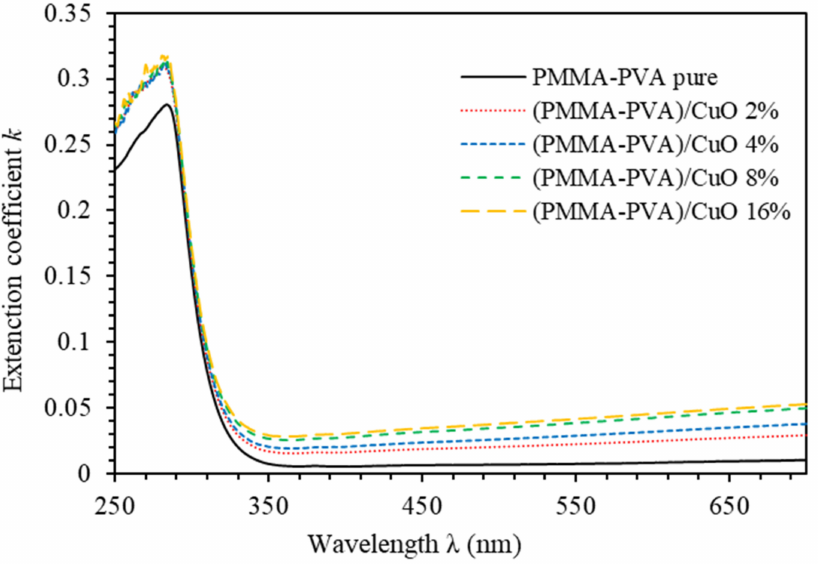
Figure 5. Extinction coefficient spectra of PMMA–PVA/CuO nanocomposite thin films as a function of wavelength for various CuO NPs